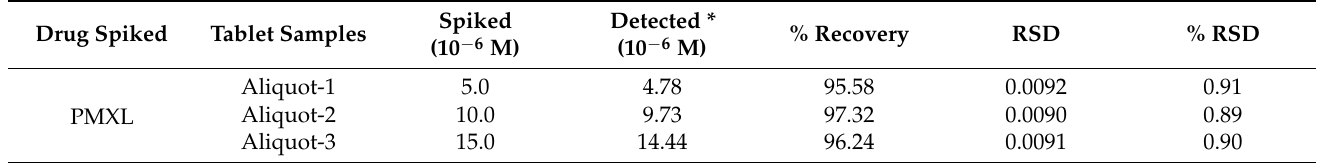
Table 2. Details of PMXL analysis in pharmaceutical drug